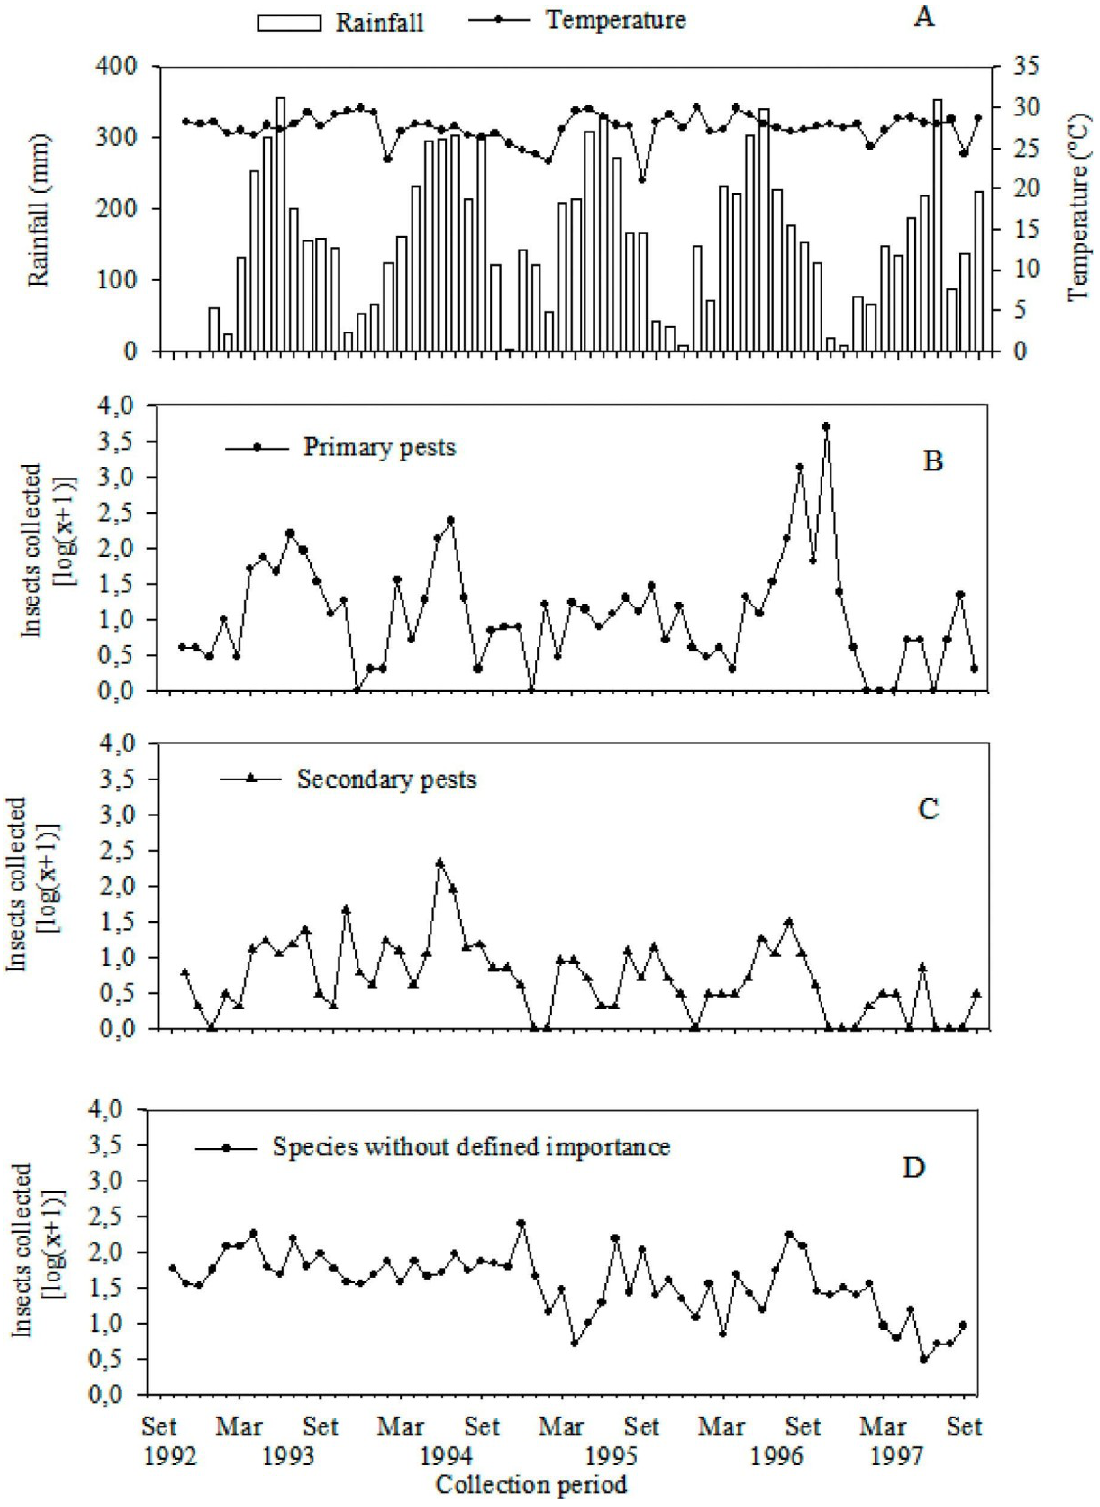
Figure 4. Rainfall (mm) and temperature (°C) ( A ), population dynamics of primary pests ( B ), secondary pests ( C ), and species with no defined importance to eucalypts ( D ) in Caracuru, Pará State,